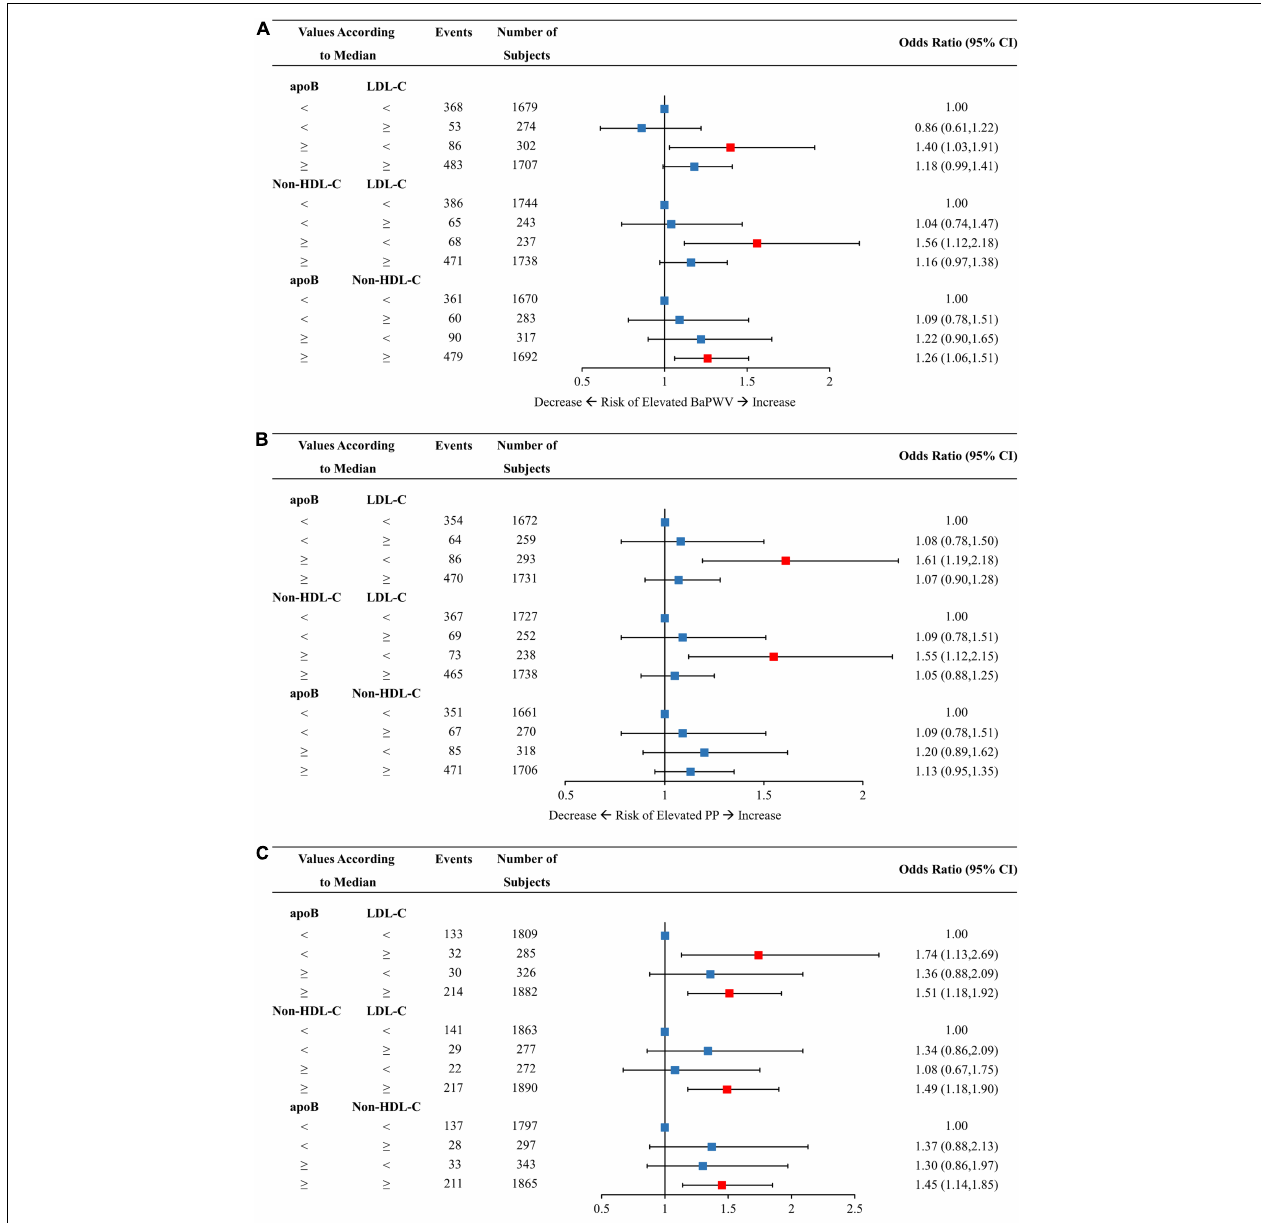
FIGURE 3 | Multivariable-adjusted odds ratios of elevated baPWV (A) , PP (B) , and CIMT (C) by discordant vs. concordant categories of apoB, non-HDL-C, and LDL-C. The concordance/discordance categories are defined based on the medians of apoB, LDL-C, and non-HDL-C concentration levels in each analysis. We use the concordant group as reference: low apoB with low LDL-C, low non-HDL-C with low LDL-C, and low apoB with low non-HDL-C. Model was adjusted for baseline age, sex, BMI, smoking status, drinking status, physical activity, glucose-lowering therapy, and lipid-lowering therapy. ApoB, apolipoprotein B; Non-HDL-C, non-high-density lipoprotein cholesterol; LDL-C, low-density lipoprotein cholesterol; BaPWV, brachial-ankle pulse wave velocity; PP, pulse pressure; CIMT, carotid intima-media thickness; CI, confidence interval; BMI, body mass